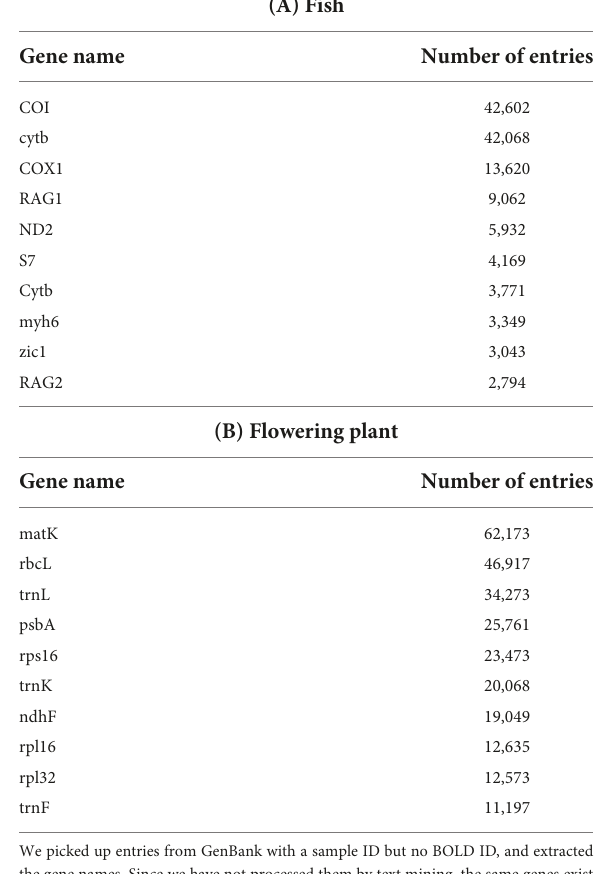
TABLE 2 Candidate list of DNA barcodes in